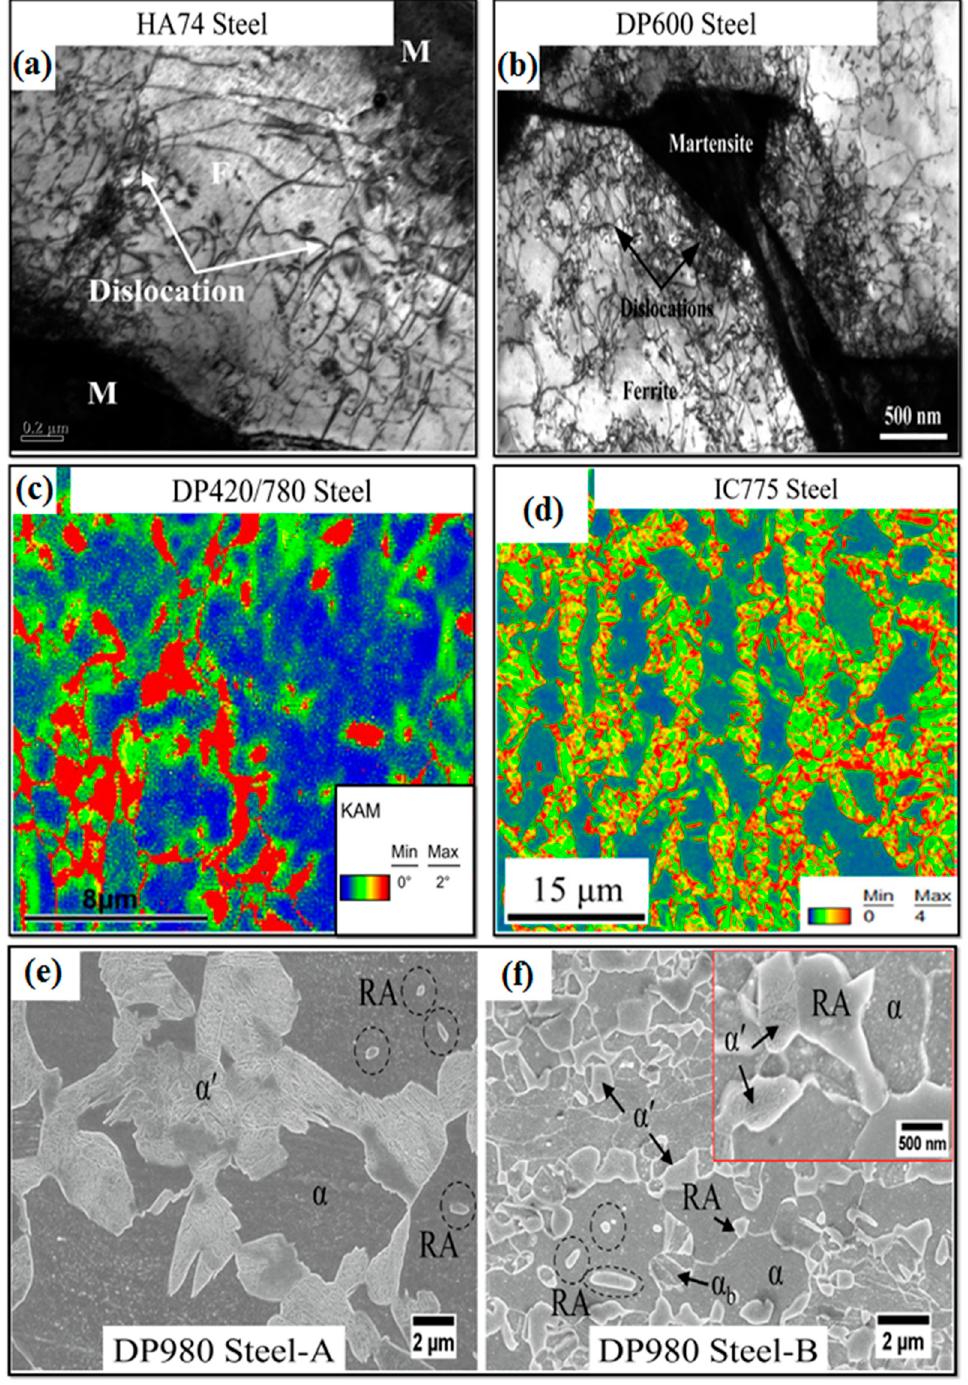
Figure 2. TEM image of DP steels: ( a ) HA74 steel [55] and ( b ) DP600 steel [60] (F = ferrite and M = martensite); KAM map of DP steels: ( c ) DP420/780 steel [58] and ( d ) IC775 steel [61]; SEM micrograph of DP steels: ( e ) DP980 steel–A and ( f ) DP980 steel–B [62]. Note: α = ferrite, α ’ = martensite, α _b = bainite, and RA = retained austenite. Reprinted with permission from ref. [55,58,60,62]. Copyright 2021 Elsevier.